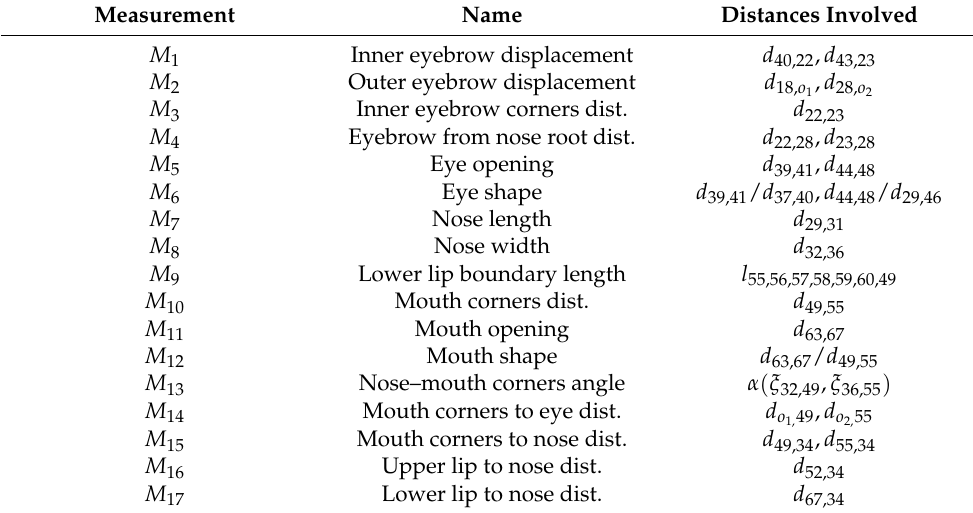
Table 1. Geometric facial measurements. d ij : the Euclidean distance between landmarks i and j ; α : the angle between two lines; ξ ij : the line defined by i and j ; l ijk the length of the curve defined by i , j , and k ; o 1 and o 2 : the centers of the right and left eye, respectively.